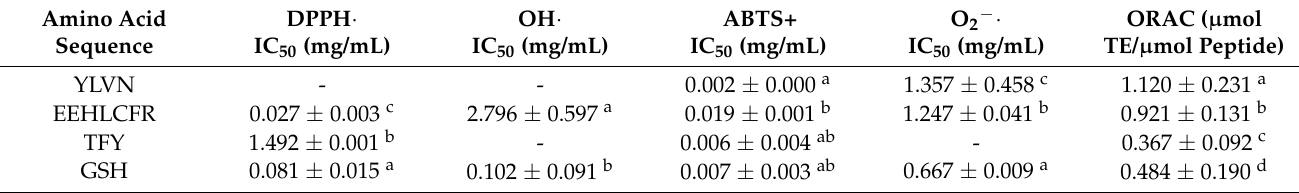
Figure 6. LC-MS/MS analysis of the active fractions. ( A ) FII-2-6-3; ( B ) FII-2-6-5; ( C ) FII-2-6-7. Table 2. Antioxidant activity of three novel antioxidant peptides in Table 1. Sequence, length, molecular mass and the hydrophobic ratio of three novel antioxidant peptides.